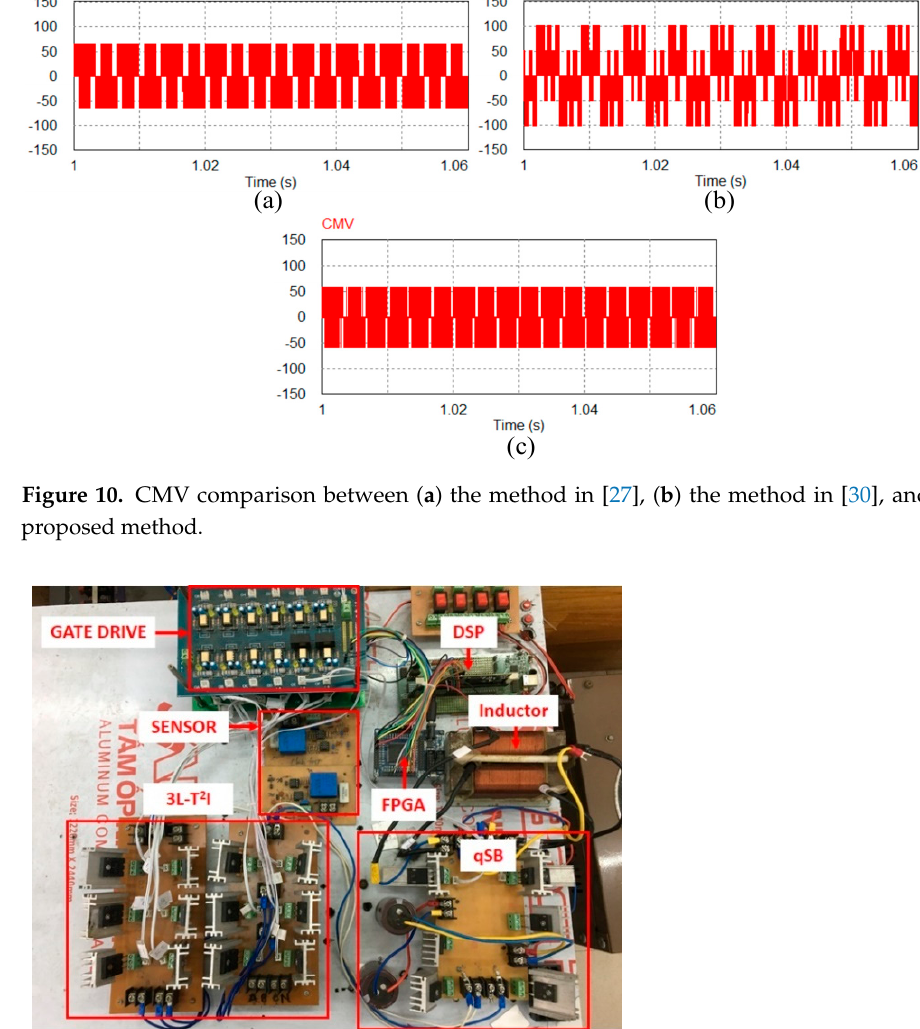
Figure 10. CMV comparison between ( a ) the method in [27], ( b ) the method in [30], and ( c ) the